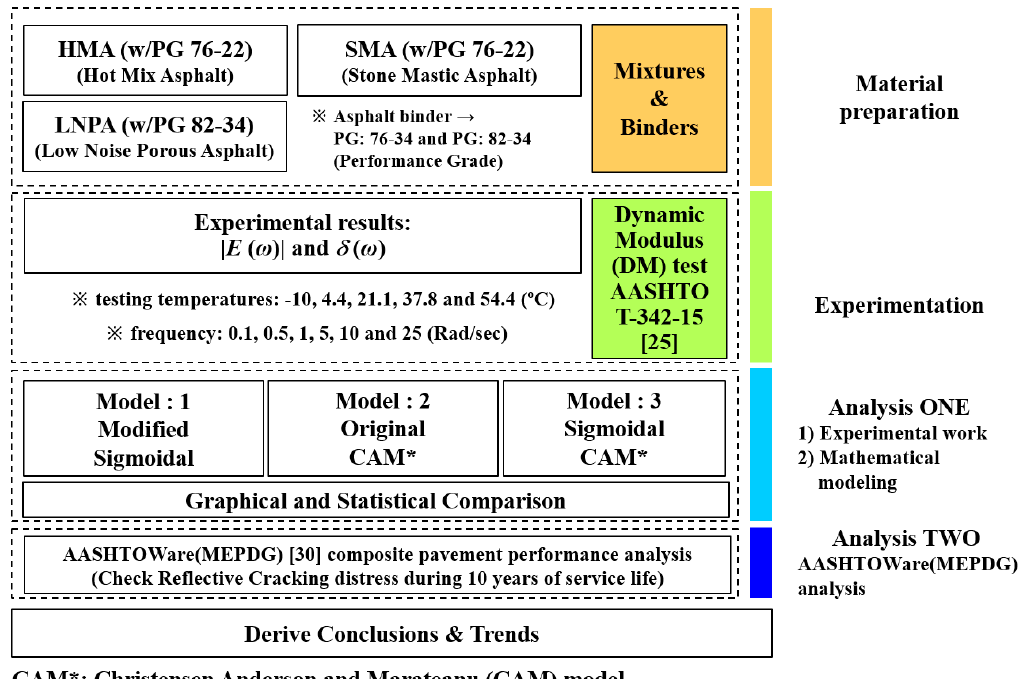
Figure 1. Schematic of the research approach. 3. Experimentation